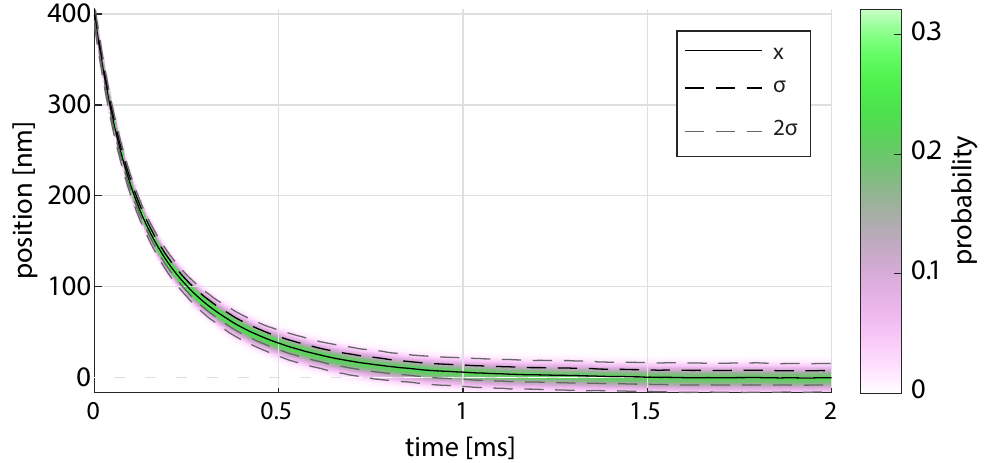
Figure 2. Binned distribution of 1000 simulated sequences of a 1.00µm radius particles falling into a trap with ω act /2 π (cid:39) 0.1 × 10 4